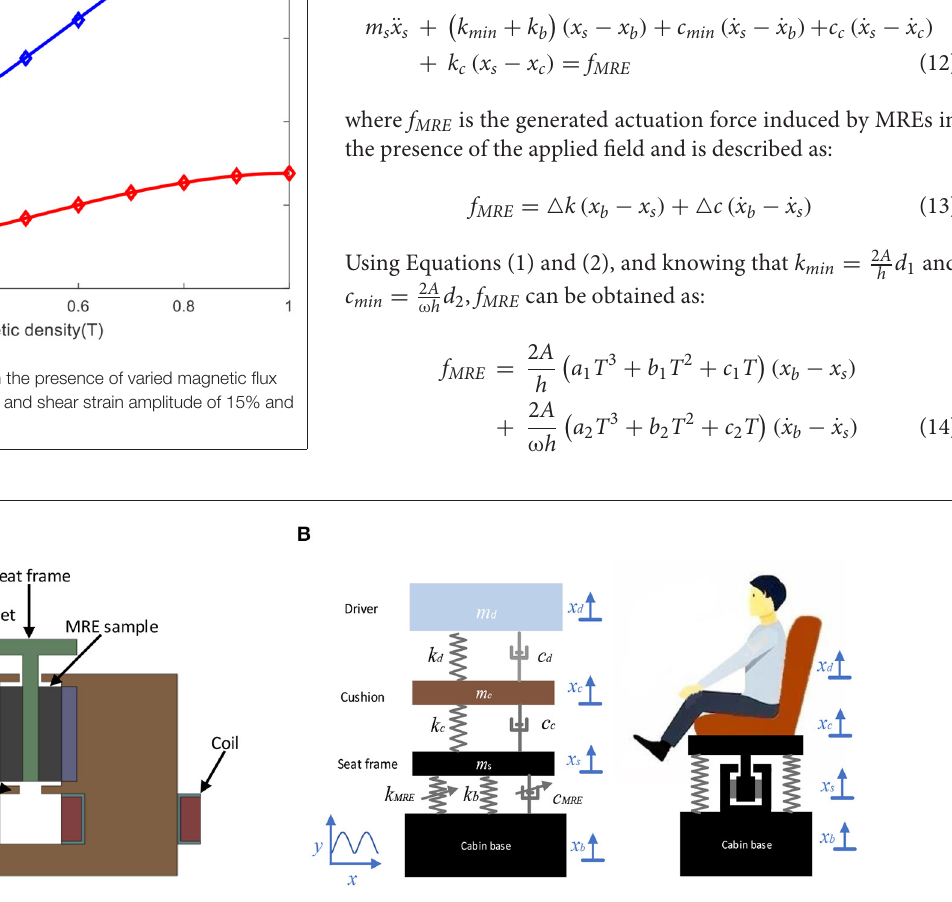
FIGURE 6 | (A) Schematic diagrams of MRE-based seat suspension isolator and (B) the modeling of the MRE-based seat isolation system.